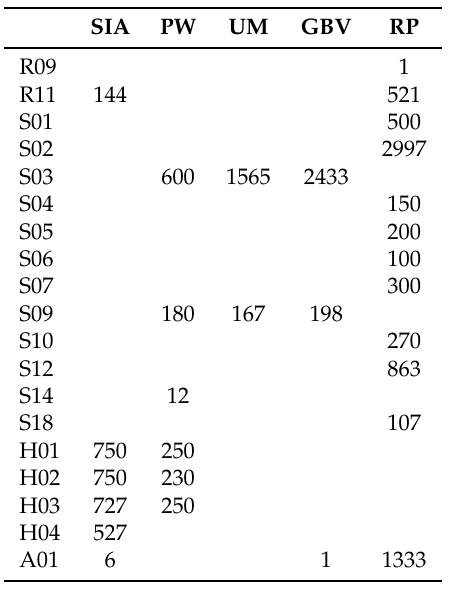
Figure 4. Location of evacuees at the end of the operation. Table 6. Distribution of evacuees at the end of the operation by category. SIA: Severely injured adults. PW: pregnant women. UM: unaccompanied minors. GBV: women susceptible to gender violence. RP: rest of the